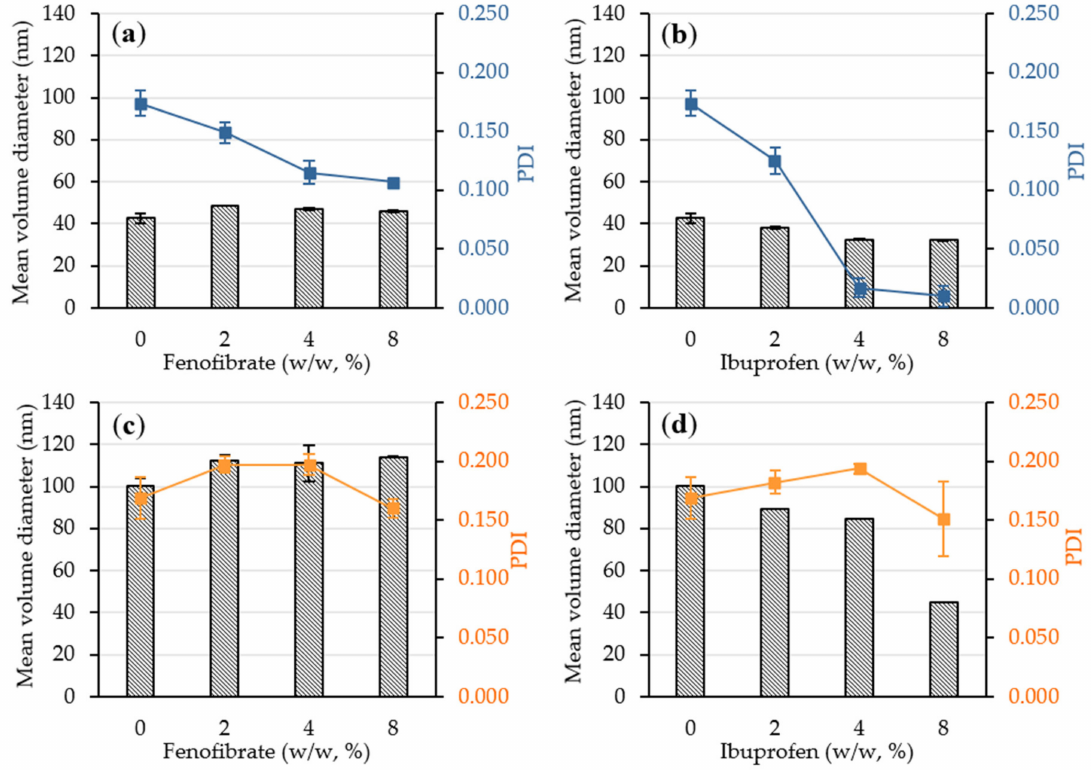
Figure 7. Droplet diameter in volume (bars) and PDI (solid lines) of NE 1 ( a , b ) and NE 2 ( c , d ) as a function of drug